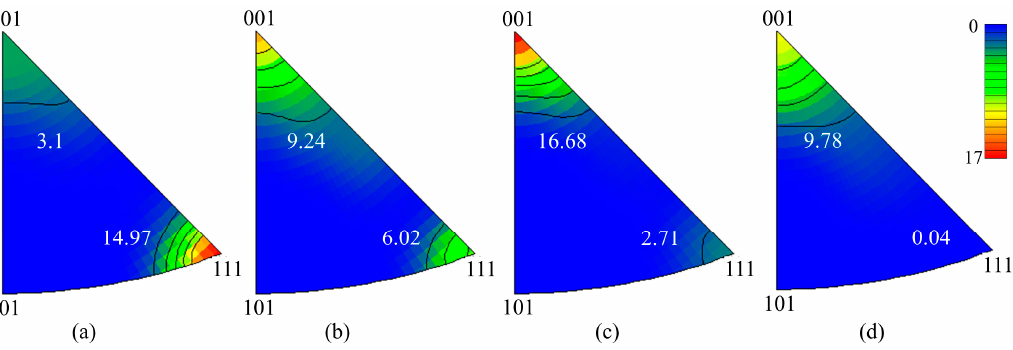
Figure 8. IPF of the extruded alloys: ( a ) λ = 7, ( b ) λ = 13, ( c ) λ = 21, ( d ) λ =